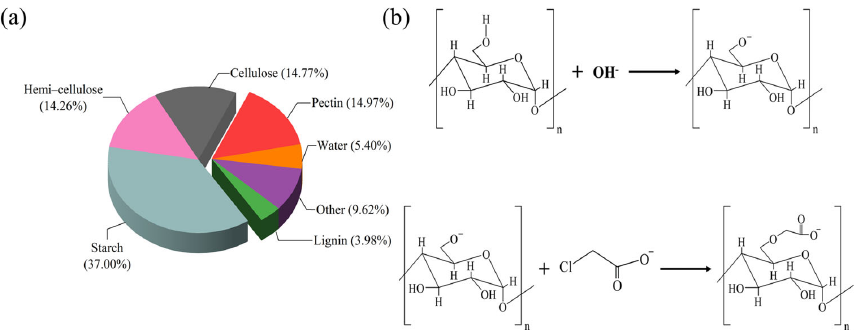
Figure 11. Composition and carboxymethyl reaction mechanism of PPS. ( a ) Compositions of PPS; ( b ) The reaction mechanism of PPS.